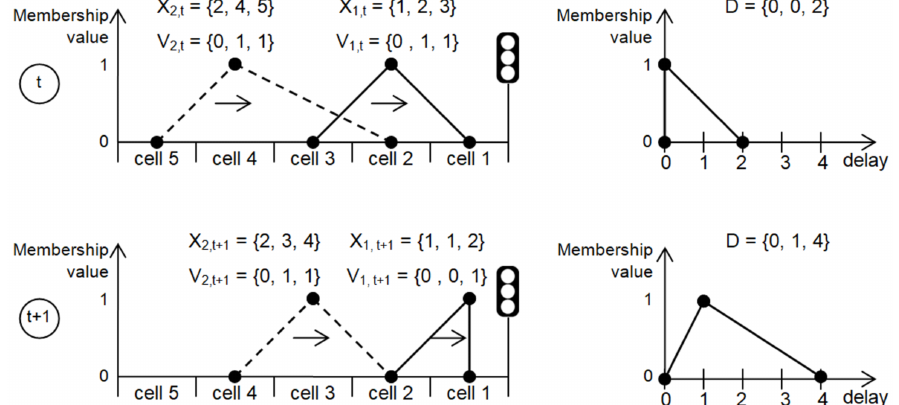
Figure 6. Evaluation of vehicles delay in traffic model based on fuzzy cellular